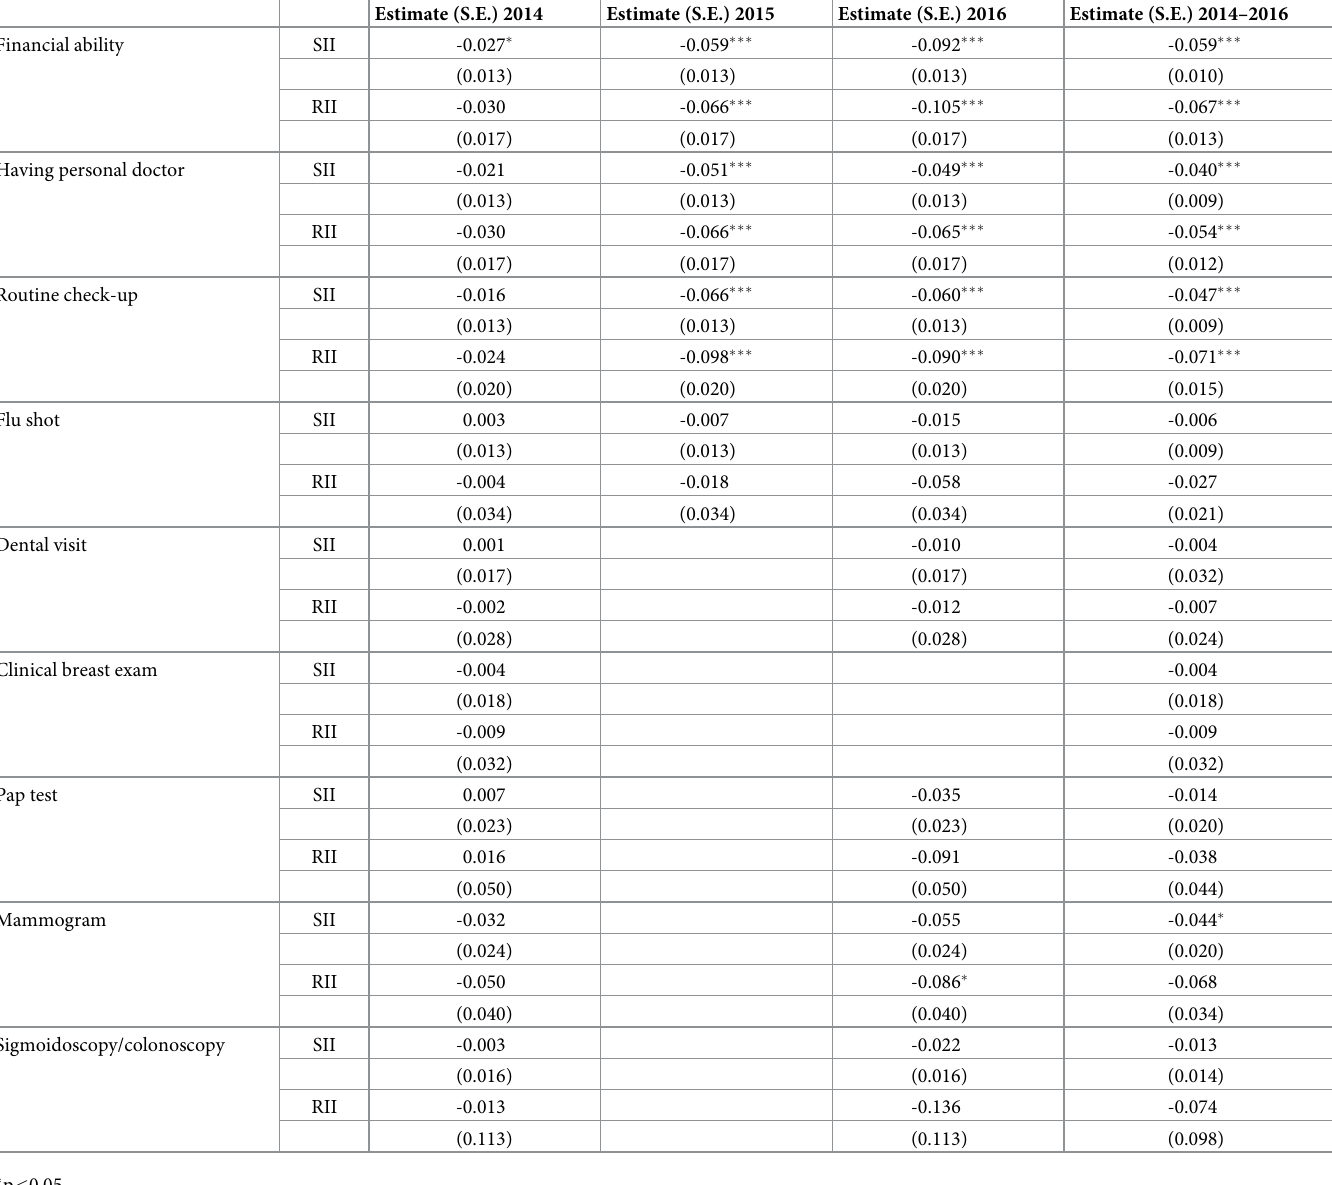
Table 3. Difference-in-differences estimates of Medicaid expansion implementation in SII and RII for use of health services between full expansion and non-expan- sion (excluding substantial and mild expansion